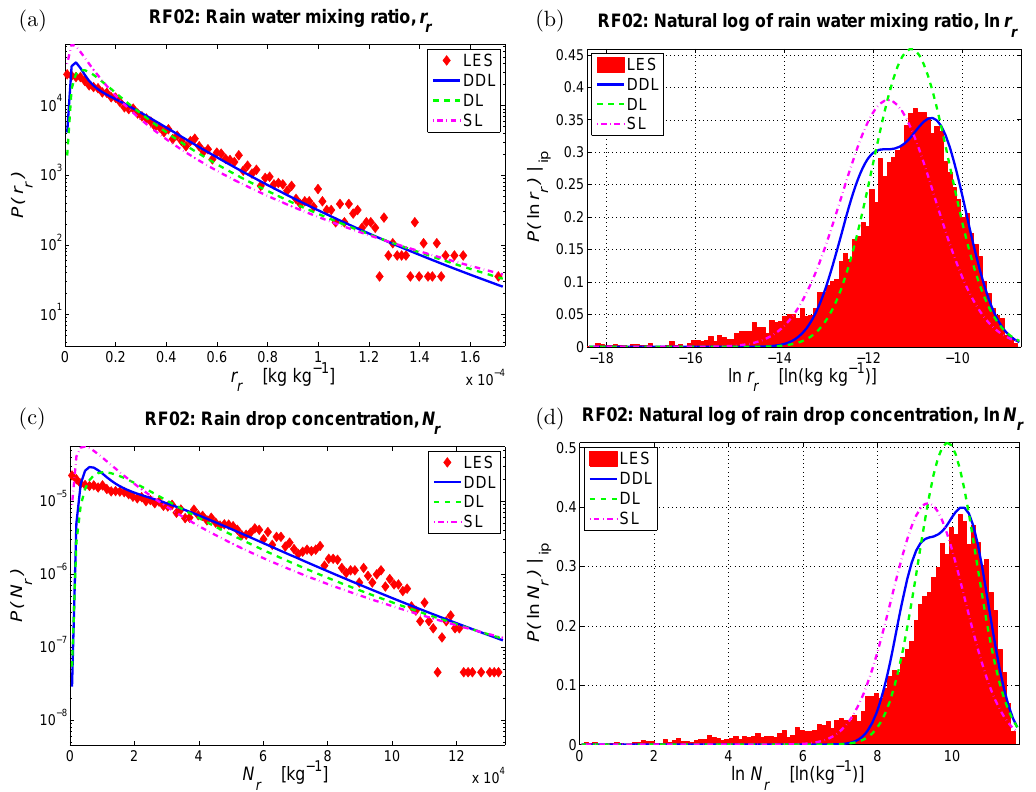
Figure 4. PDFs of rain in the DYCOMS-II RF02 drizzling stratocumulus case at an altitude of 400m and a time of 330min. The SAM LES results are in red, the DDL results are blue solid lines, the DL results are green dashed lines, and the SL results are magenta dashed-dotted lines. (a) The marginal distribution of r r with the delta at r r = 0 omitted. (b) The marginal distribution of ln r r using the “in-precipitation PDF.” This is the in-precipitation marginal PDF in Gaussian space. (c) The marginal distribution of N r with the delta at N r = 0 omitted. (d) The marginal distribution of ln N r using the “in-precipitation PDF”, which is the in-precipitation marginal PDF in Gaussian space. Owing to relatively low in-precipitating variance, the three hydrometeor PDF shapes are all a close match to SAM